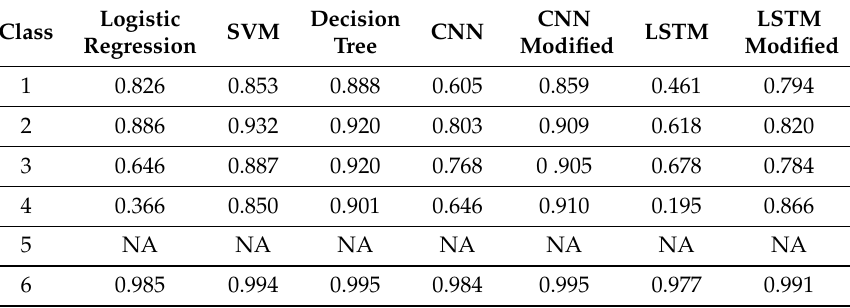
Table 14. Fin whale classifier F1-score results (including results from the CNN and LSTM classifiers with modified input data